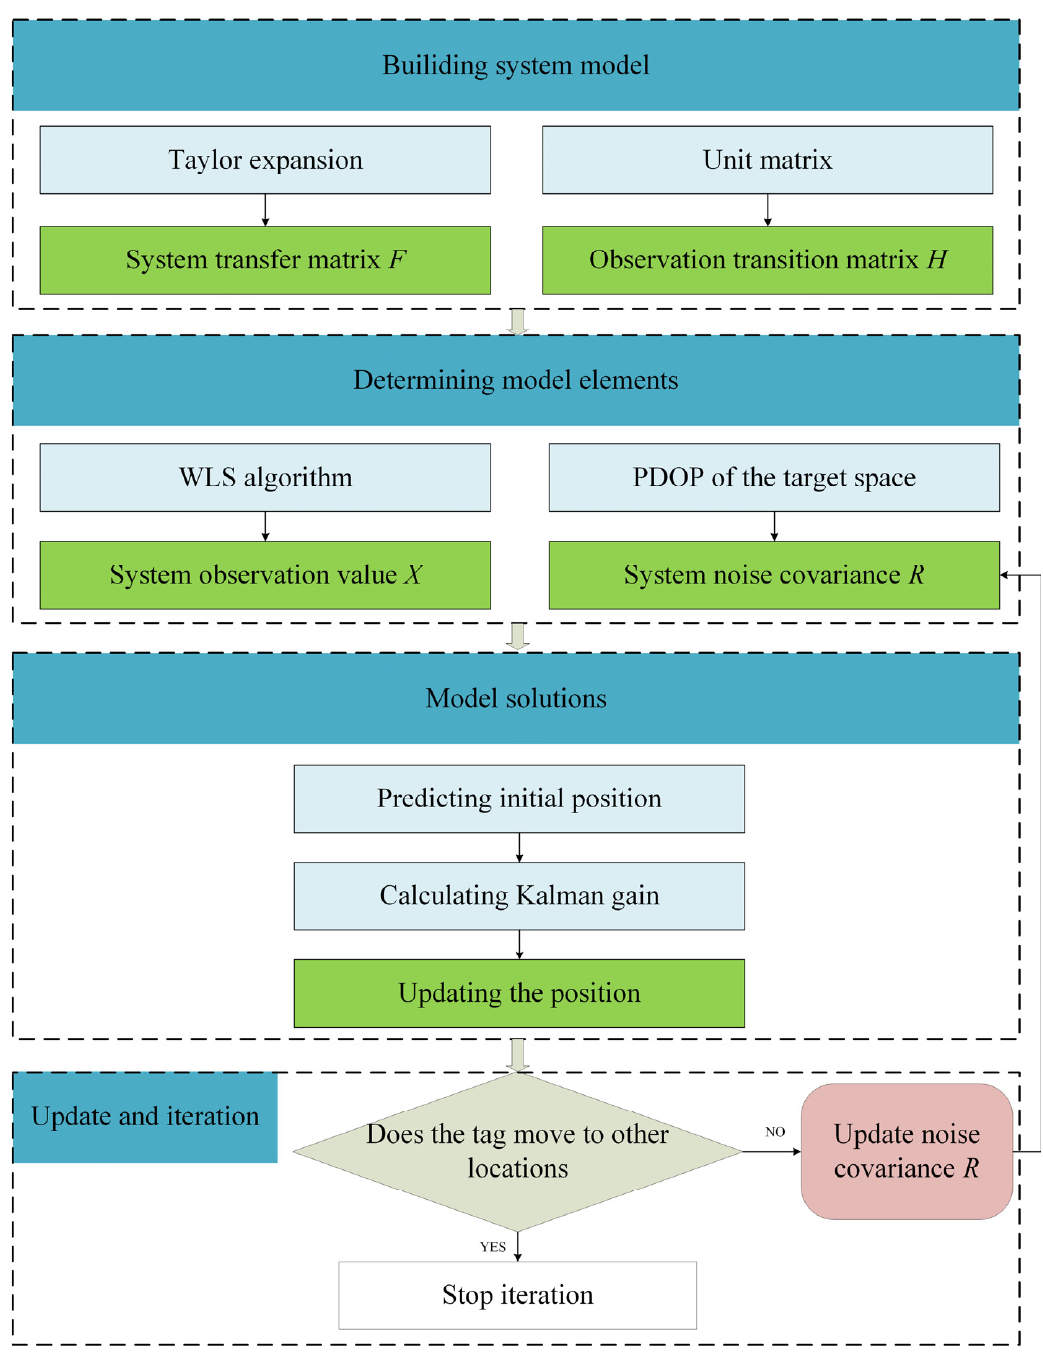
Figure 2. Flow chart of the fusion positioning algorithm.